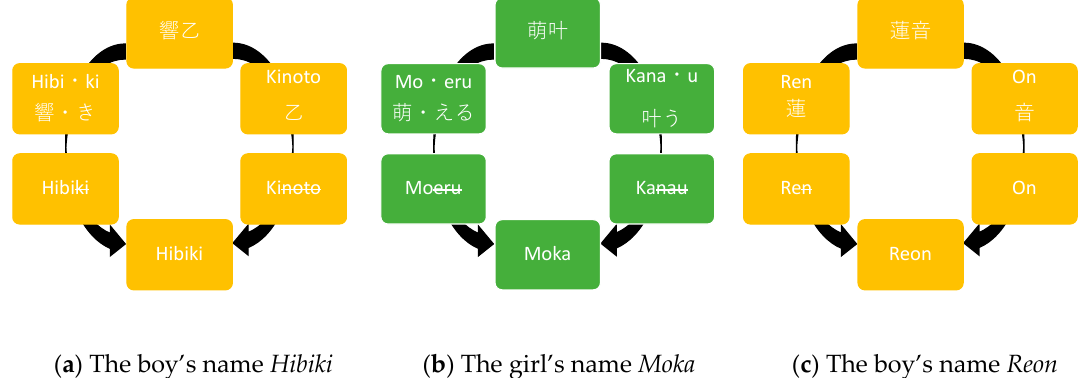
Figure 1. Examples of new names. The uppermost boxes in ( a – c ) show how the names are written orthographically. The second level of boxes show the closest standard reading for each kanji from which the phonetic form could have been derived; the third boxes show how the readings must be altered in order to obtain the final phonetic form in the lowermost box. The symbol ‘ · ’ indicates parts of verbs that are conjugating, which are usually written in kana.